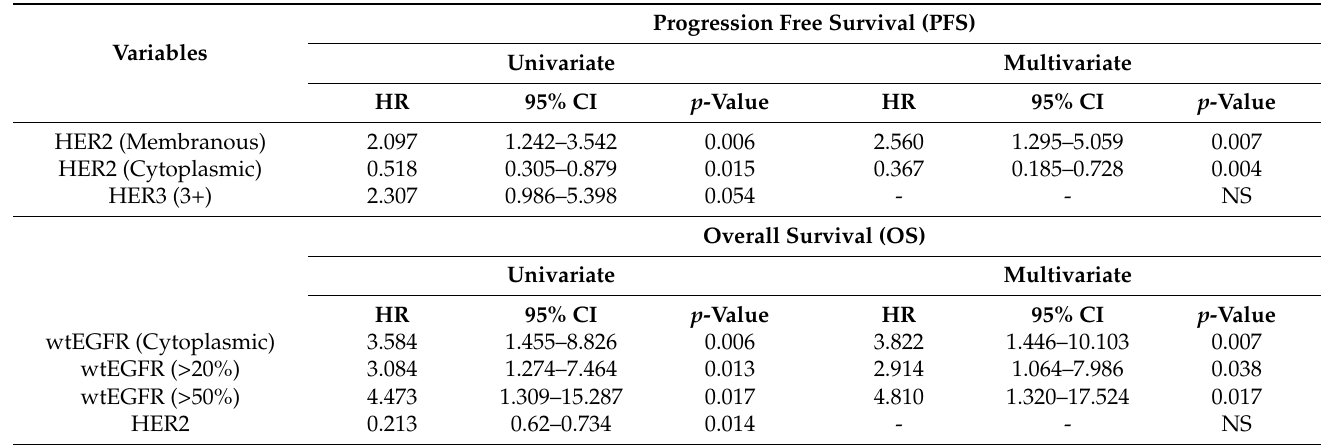
Table 4. Univariate and multivariate analysis related to PFS and OS in 144 mCRC treated with anti-EGFR mAb cetuximab. p -Value of ≤ 0.05 was considered